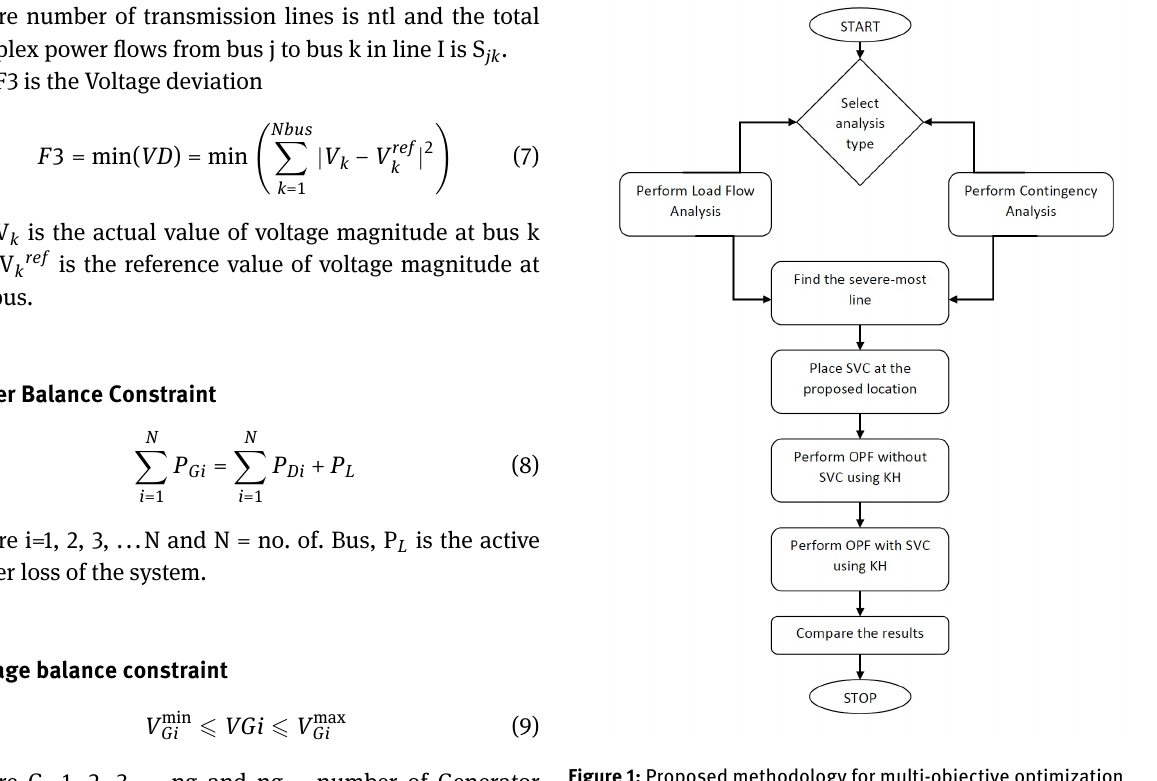
Figure 1: Proposed methodology for multi-objective optimization using